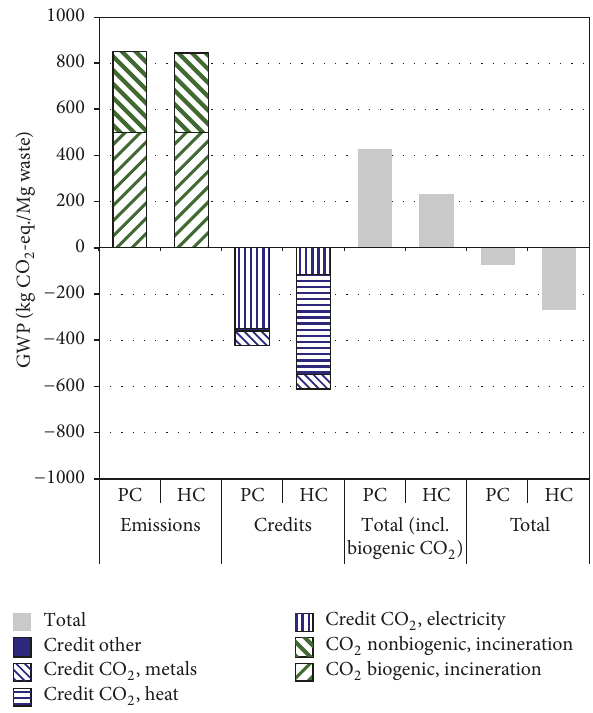
Figure 8: GWP of the power-conducted (PC) and heat-conducted (HC) WtE